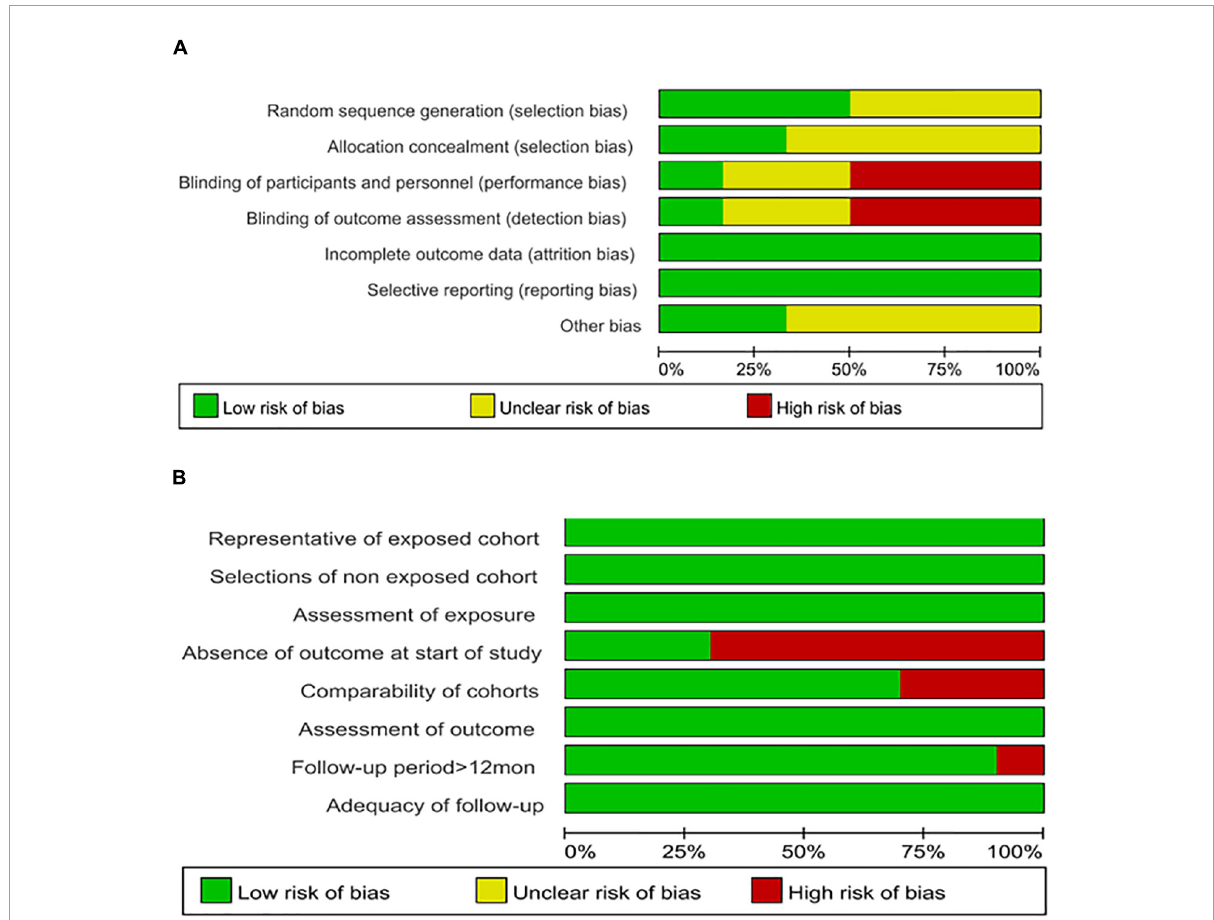
FIGURE1 (A) Assessment of methodological quality of the included randomized studies using the Cochrane Risk of Bias Assessment Tool. (B) Assessment of methodological quality of the included cohort studies using the Newcastle–Ottawa Quality Assessment Scale. Stacked bars represent the proportion of studies with a high (red), unclear (yellow), or low (green) risk of bias and applicability